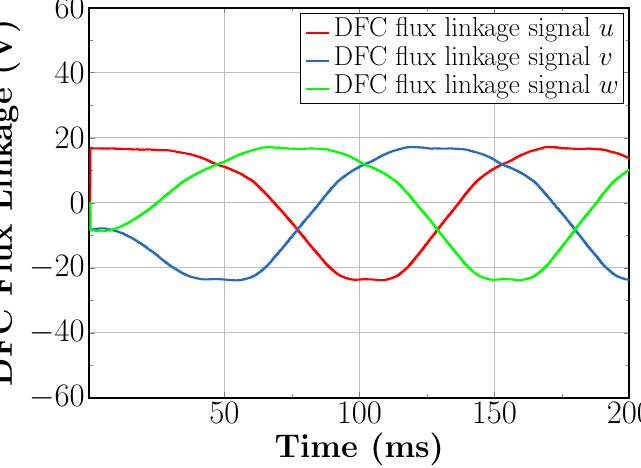
Figure 23. Sensorless speed control for 100 RPM, DFC flux linkage signals.